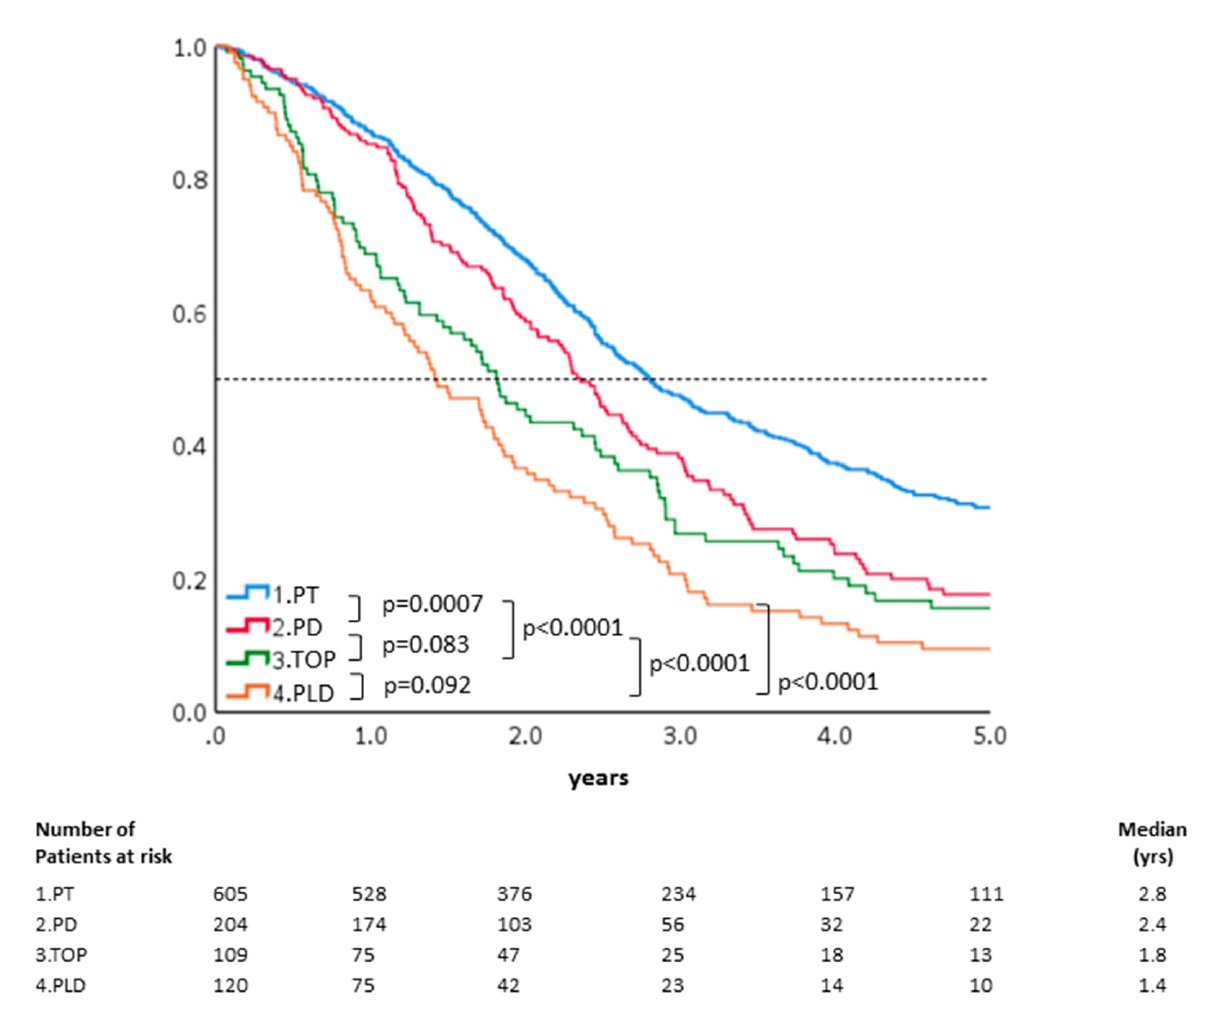
Figure 2. OS of the 1038 patients treated with different chemotherapeutic regimens. The estimated probability of five-year OS was 31% in the PT group, 18% in the PD group, 16% in the TOP group, and 10% in the PLD group. The PT group also showed better five-year OS compared with the PD group ( p < 0.001, by log-rank test).